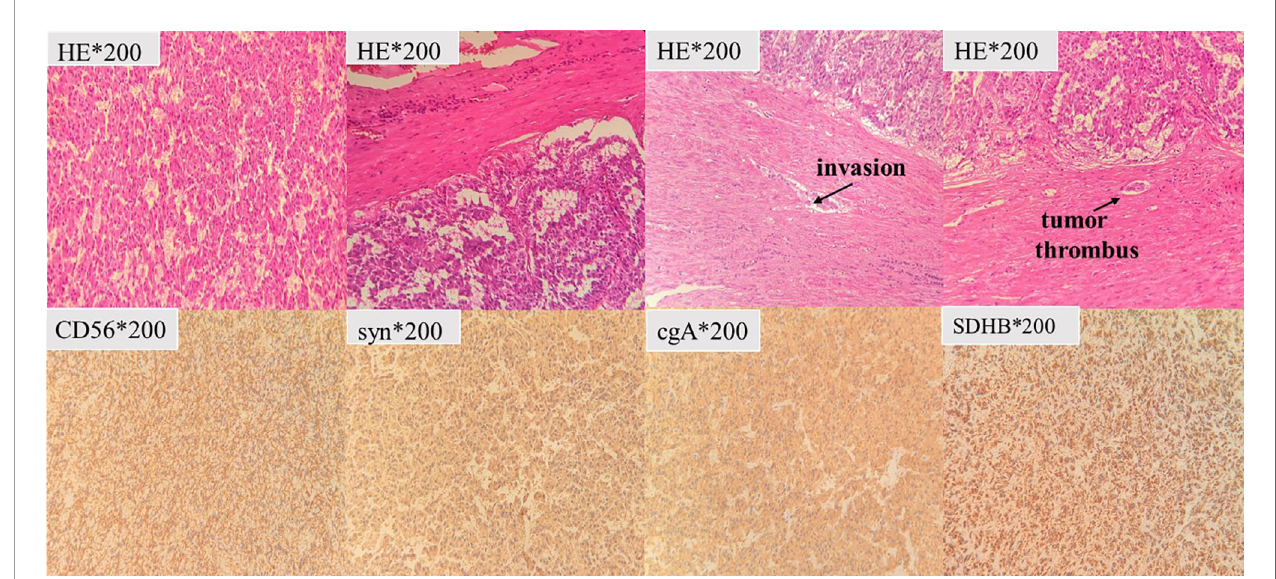
FIGURE 3 | Tumor cells are diffusely distributed, with beam-like structures and capsular invasion. CD56, syn and cgA expression is positive, supporting the diagnosis of